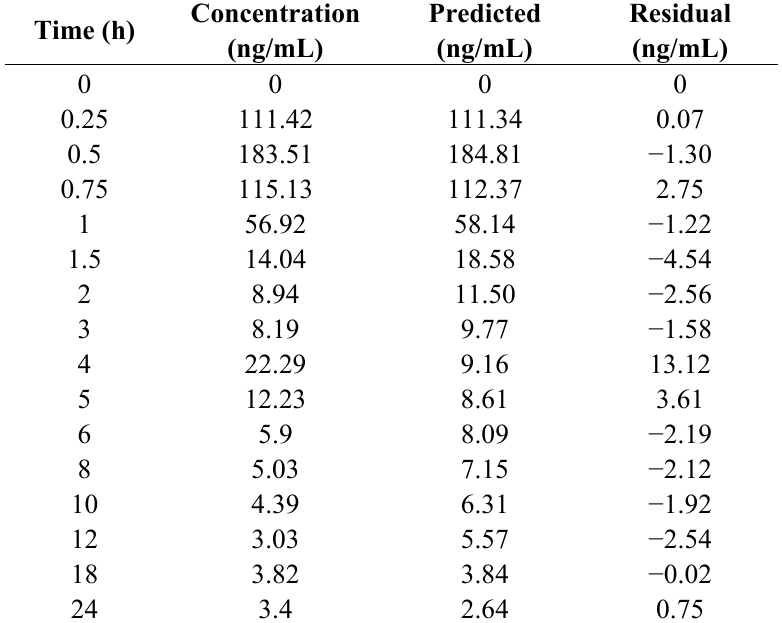
Table 2. Observed, predicted plasma concentrations and residuals for a two-compartment model with lag